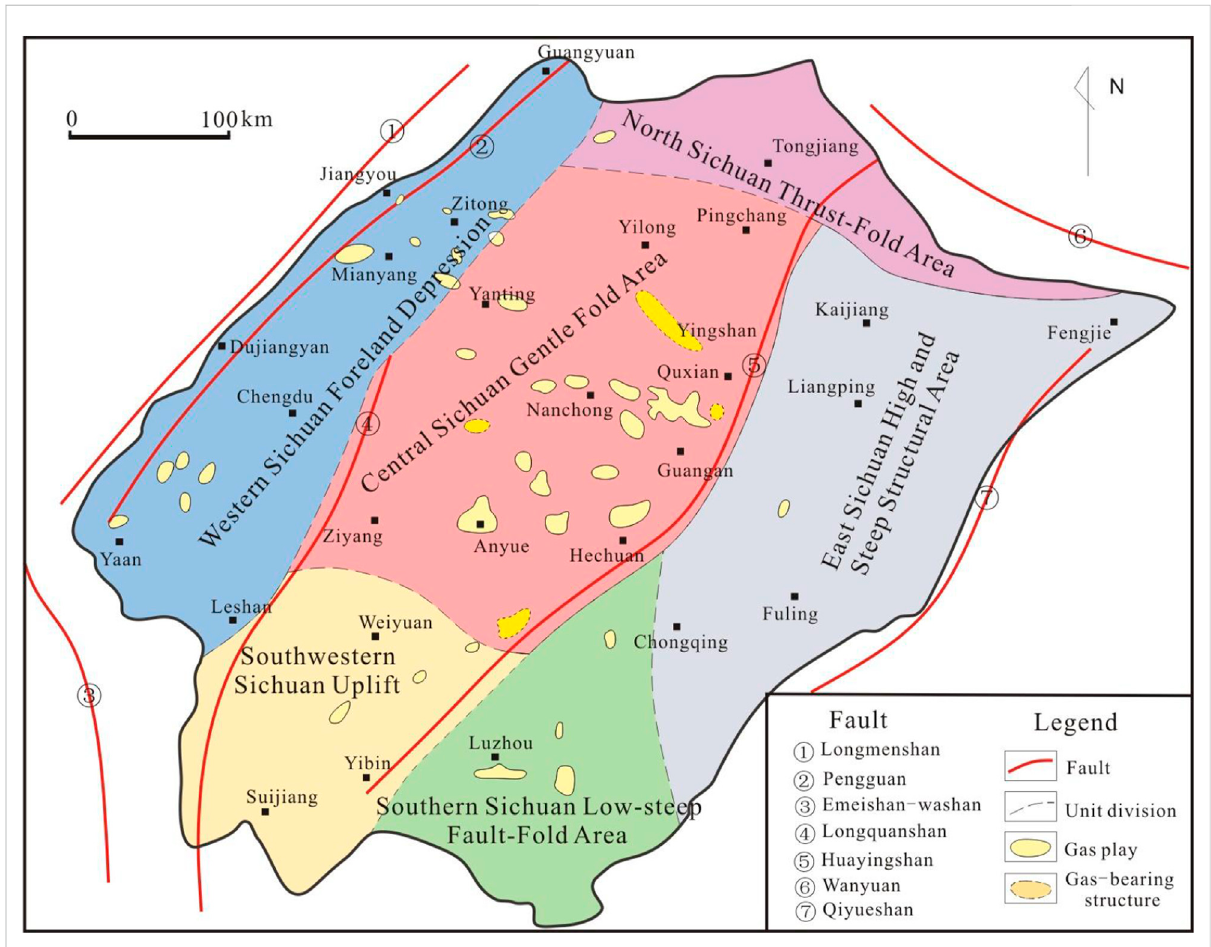
FIGURE 1 Structural location and gas reservoir distribution in the Sichuan